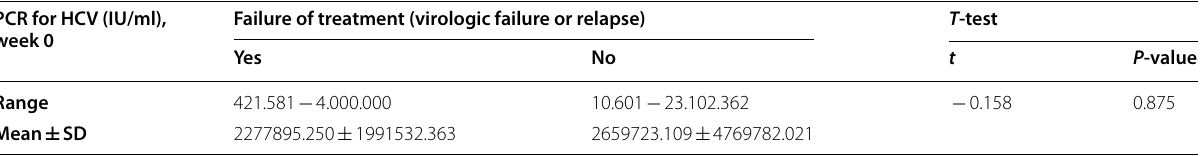
Table 8 Relation between HCV viral load and failure of treatment (virologic failure or relapse) PCR for HCV (IU/ml), Failure of treatment (virologic failure or week 0